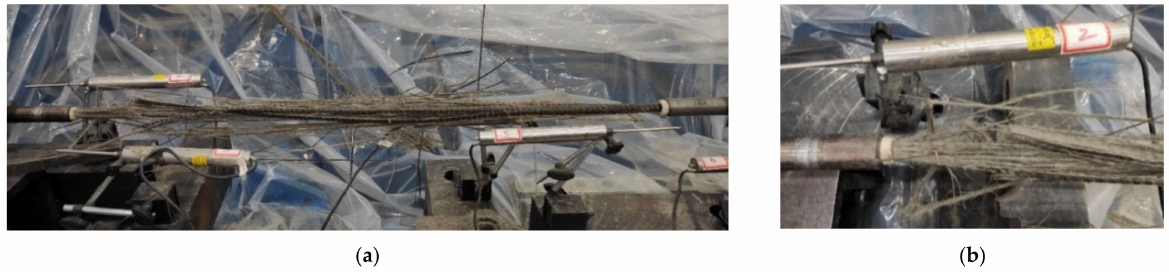
Figure 4. Fracture of the BFRP tendon: ( a ) failure mode; ( b ) anchor without obvious